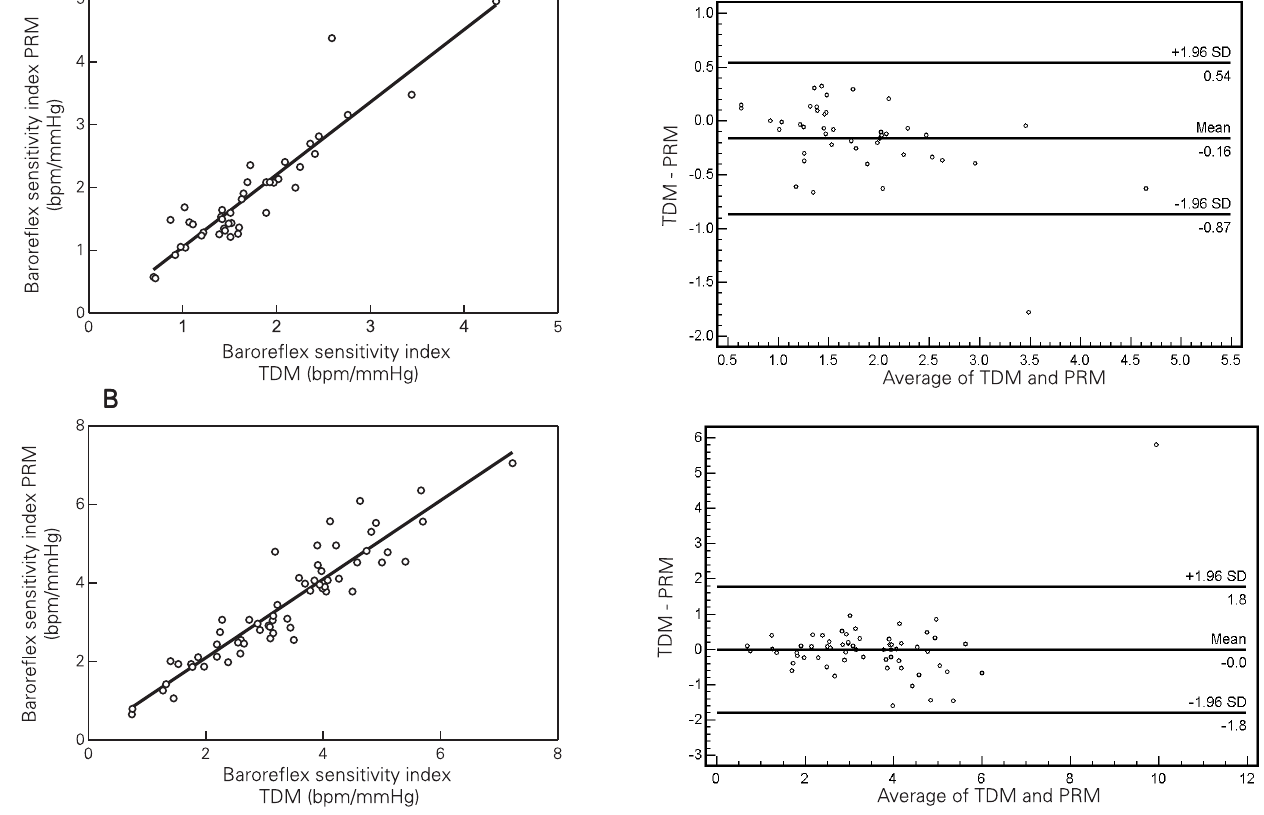
Figure 3. Regression analysis (left panels) and Bland and Altman plots (right panels) for reflex bradycardia indexes after phenylephrine bolus infusions (A) and for reflex tachycardia indexes after sodium nitroprusside bolus infusions (B). The average values from the PRM and TDM are presented on the abscissa and the ordinates show the differences between the two methods against a mean difference (Mean, middle horizontal line). Upper (+1.96 SD) and lower (-1.96 SD) limits of agreement are shown as horizontal lines. Circles represent the differences between methods subtracted from a mean (Mean) difference. PRM = proposed method; TDM = traditional